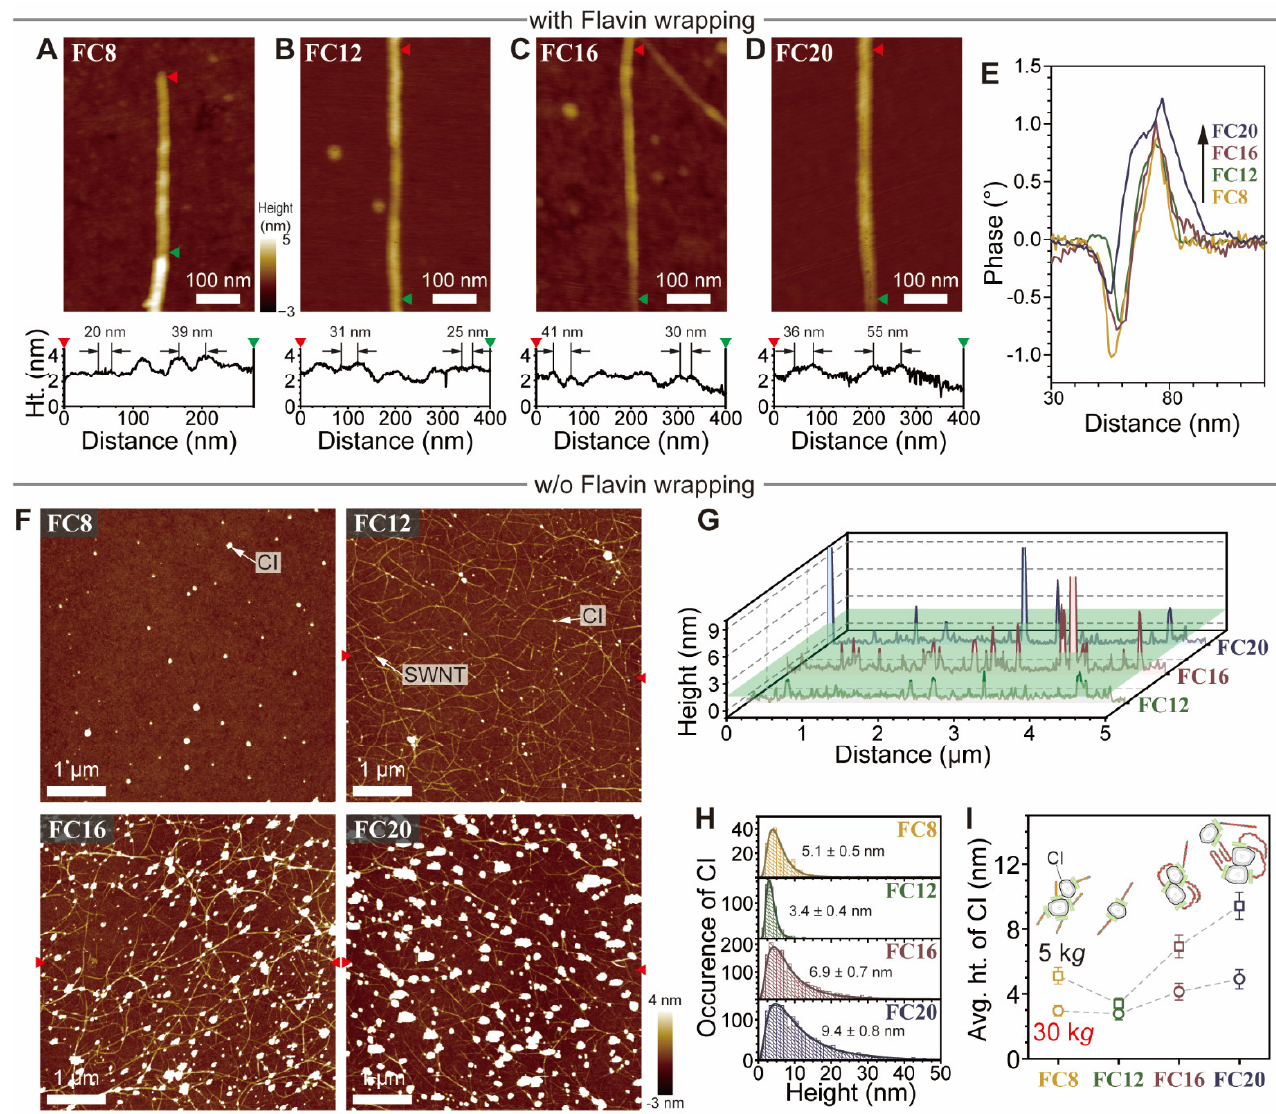
Figure 7. Morphologies of SWNT and CIs in FC8 -, FC12 -, FC16 - and FC20 -PSWNT dispersions centrifuged at 5 k g with or without flavin wrappings. Cases with flavin wrapping: AFM height images of ( A ) FC8 -, ( B ) FC12 -, ( C ) FC16 -, and ( D ) FC20 -wrapped SWNT on mica. (Bottom) height traces of flavin wrapping on SWNT along the length indicated by triangles in images. ( E ) Their phase traces along the dashed lines as shown in Figure S15A to S15D. Cases without flavin wrapping: ( F ) height images of each dispersion deposited on a 285-nm-thick SiO 2 /Si substrate and ( G ) height profiles extracted from pair of triangles in ( F ). Limit of individualized PSWNT is indicated by a 1.6-nm green plane. ( H ) Height histograms of CIs fitted by using a Lognormal function. Average height and standard deviation are listed. ( I ) Plot of average height of CIs vs. l S of the flavin surfactants according to centrifugal force. Cartoons illustrate the interaction of CIs and flavin derivatives.